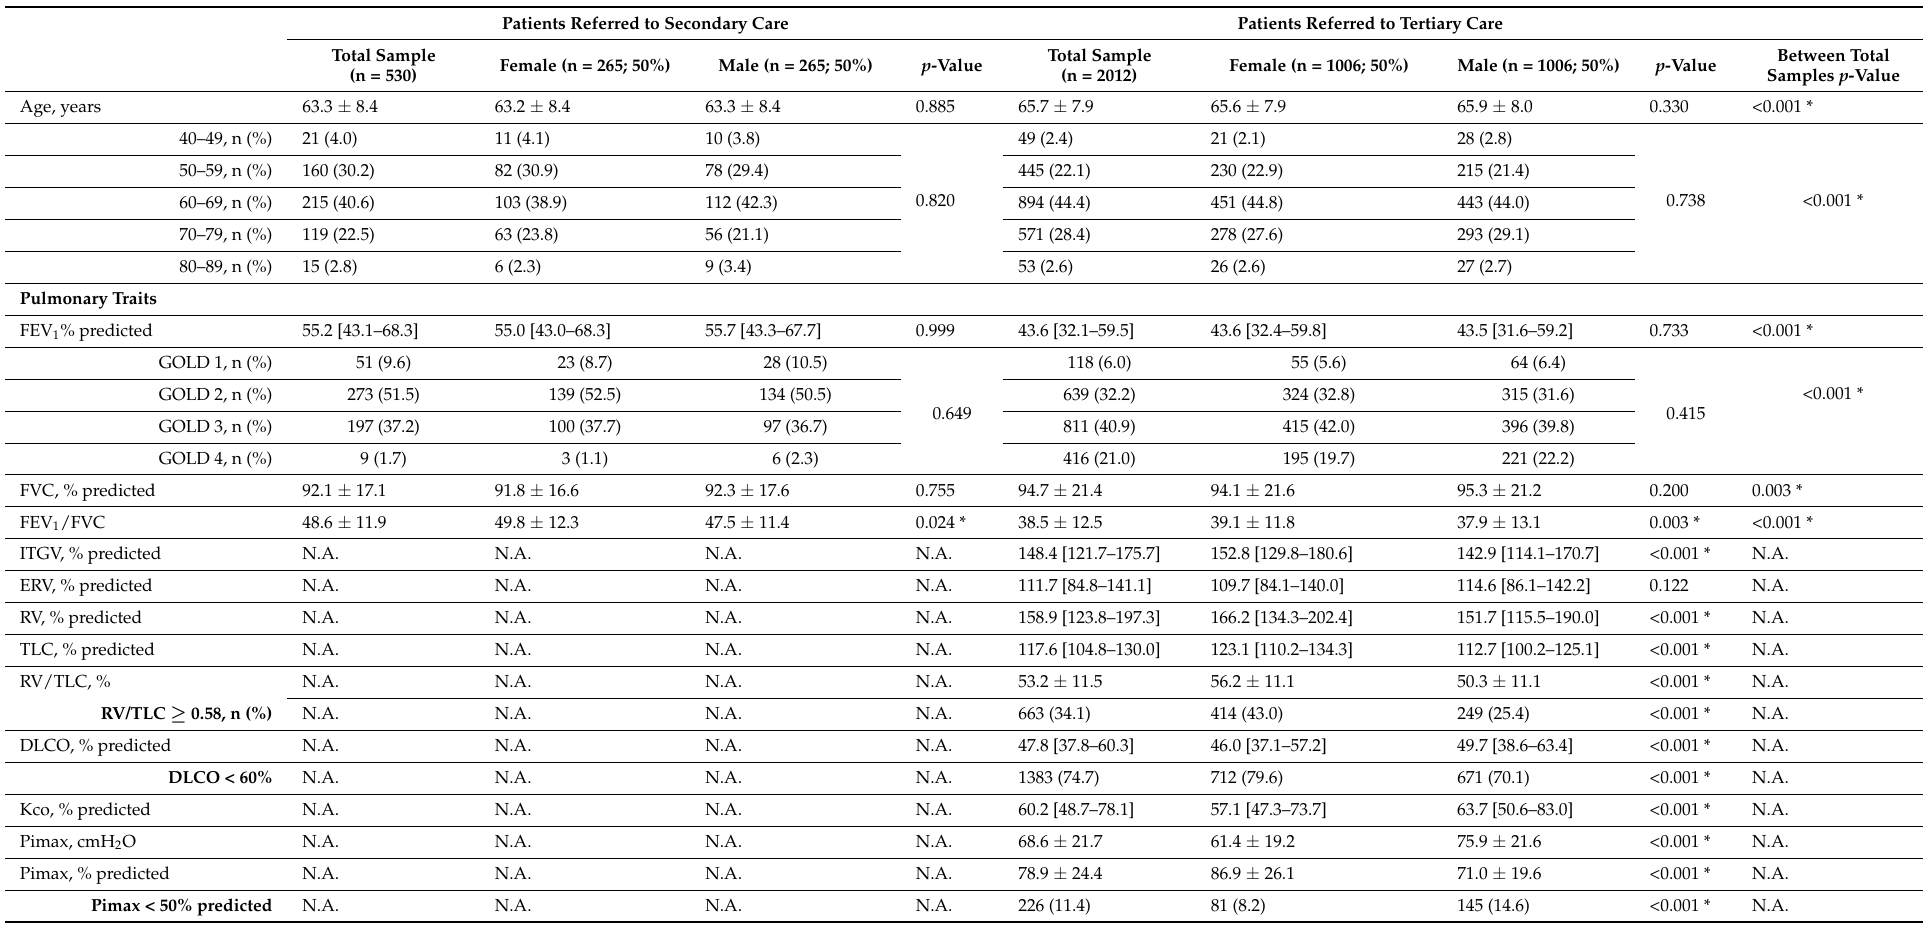
Table 2. Sociodemographic characteristics and pulmonary traits of female and male patients with chronic obstructive pulmonary disease (COPD) and comparison between secondary care (n = 530) and tertiary care samples (n =